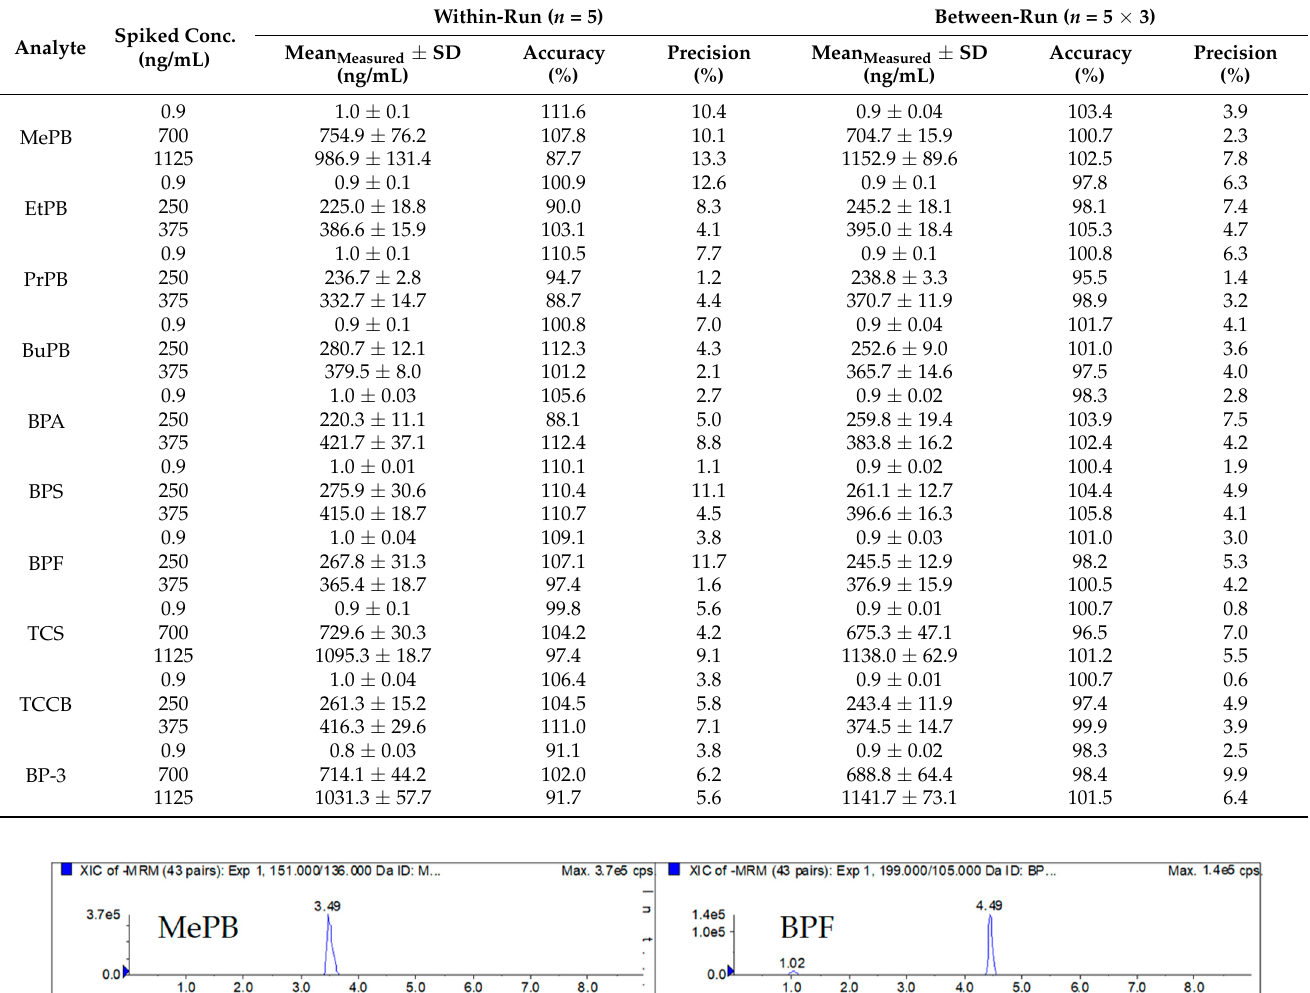
Table 4. Within-run and between-run accuracy and precision.